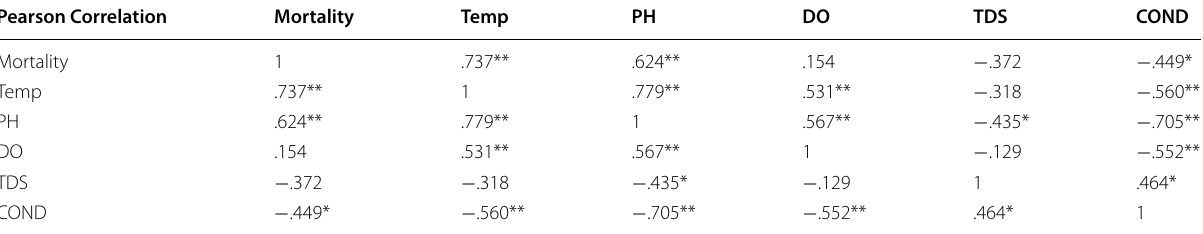
Table 3 Correlations of mean mortality values and mean values of physicochemical parameters of ethanolic leaf extract of Ricinus communis